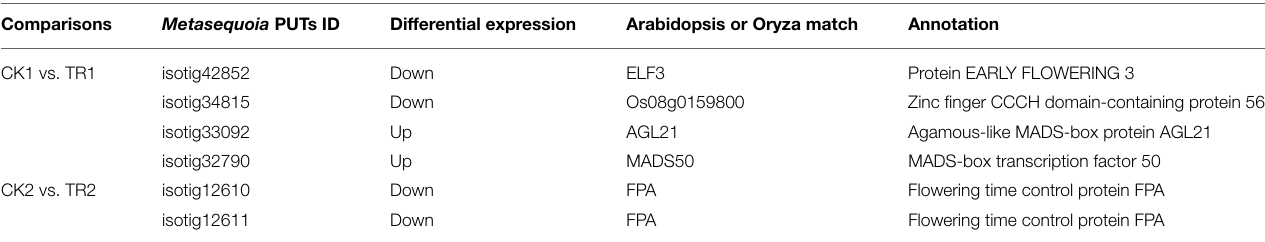
TABLE 2 | Six differentially expressed genes identified in hormone-treated shoots undergoing male bud initiation.